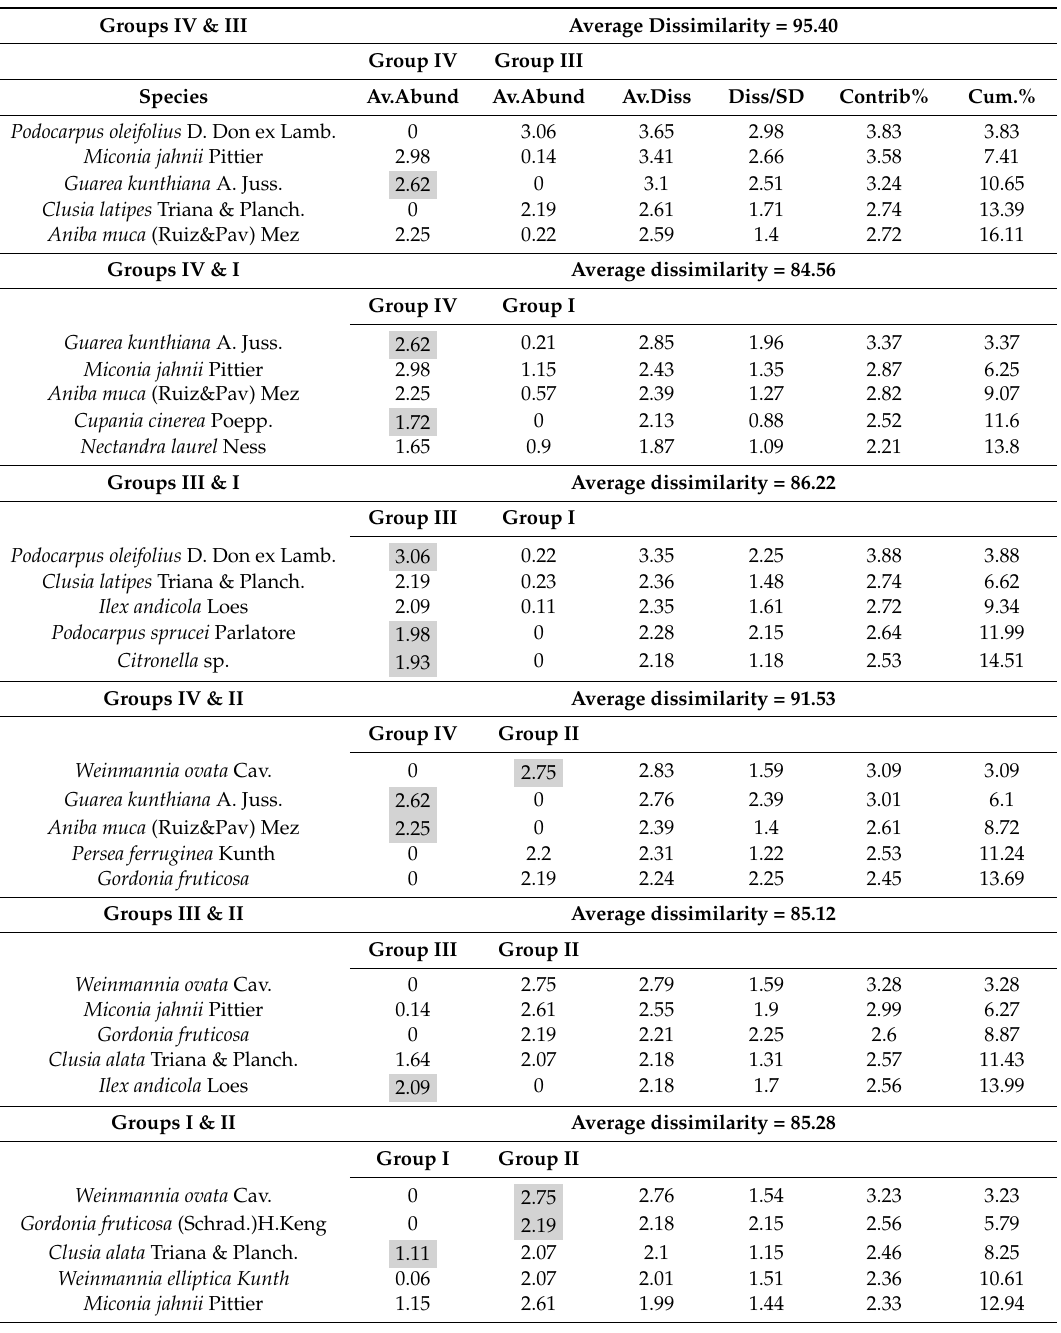
Table 3. Floristic dissimilarity values between groups and species that contribute with their presence and abundance to the floristic